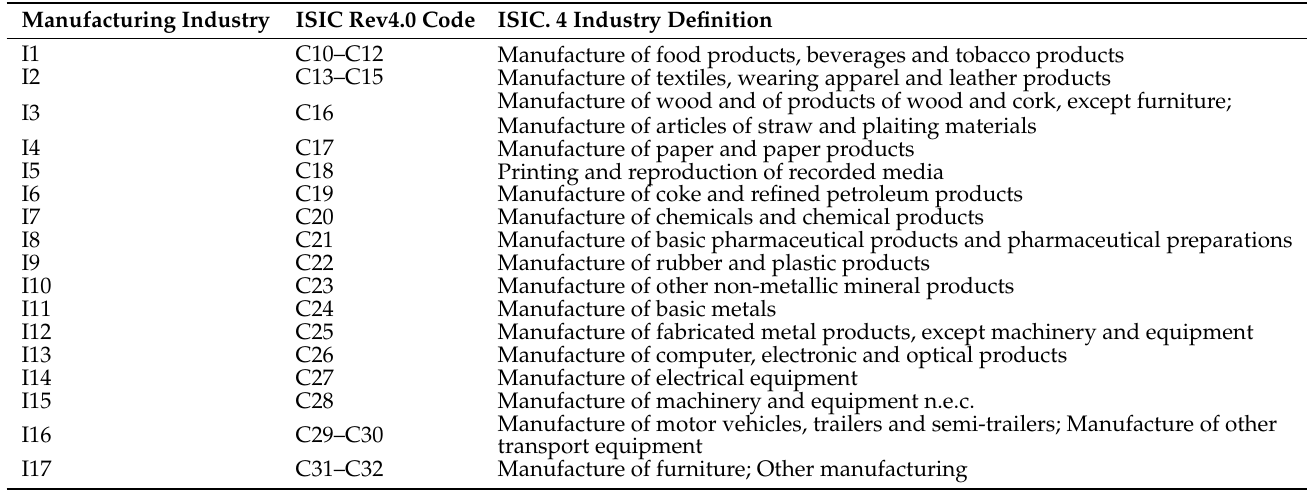
Table 3. List of 17 manufacturing industries.